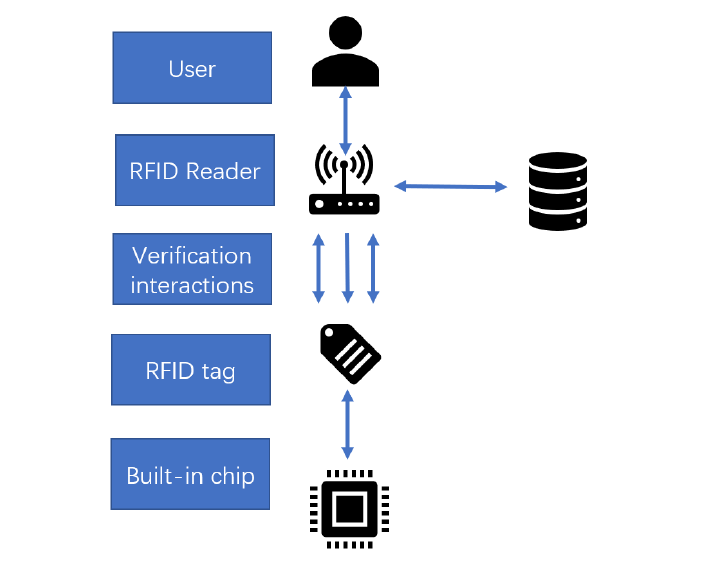
Figure 9. The workflow of smart RFID authentication system structure [108].